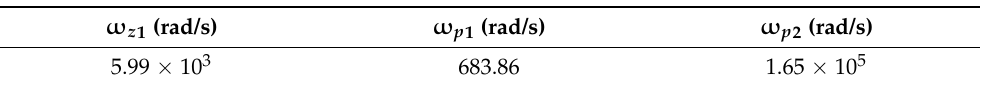
Table 3. Analog controller coefficients.